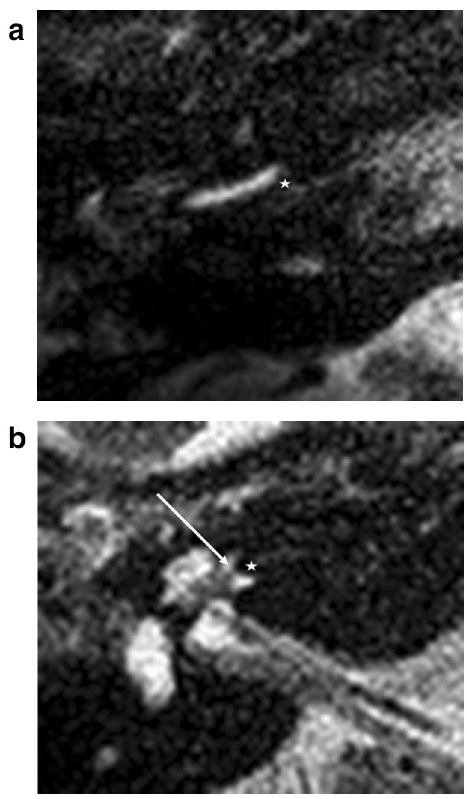
Figure 1. Straight electrodes, basal turn. ( a ) Flex 28, ( b ) SlimJ. Star represents diminishing electrode signal, arrow represents basilar